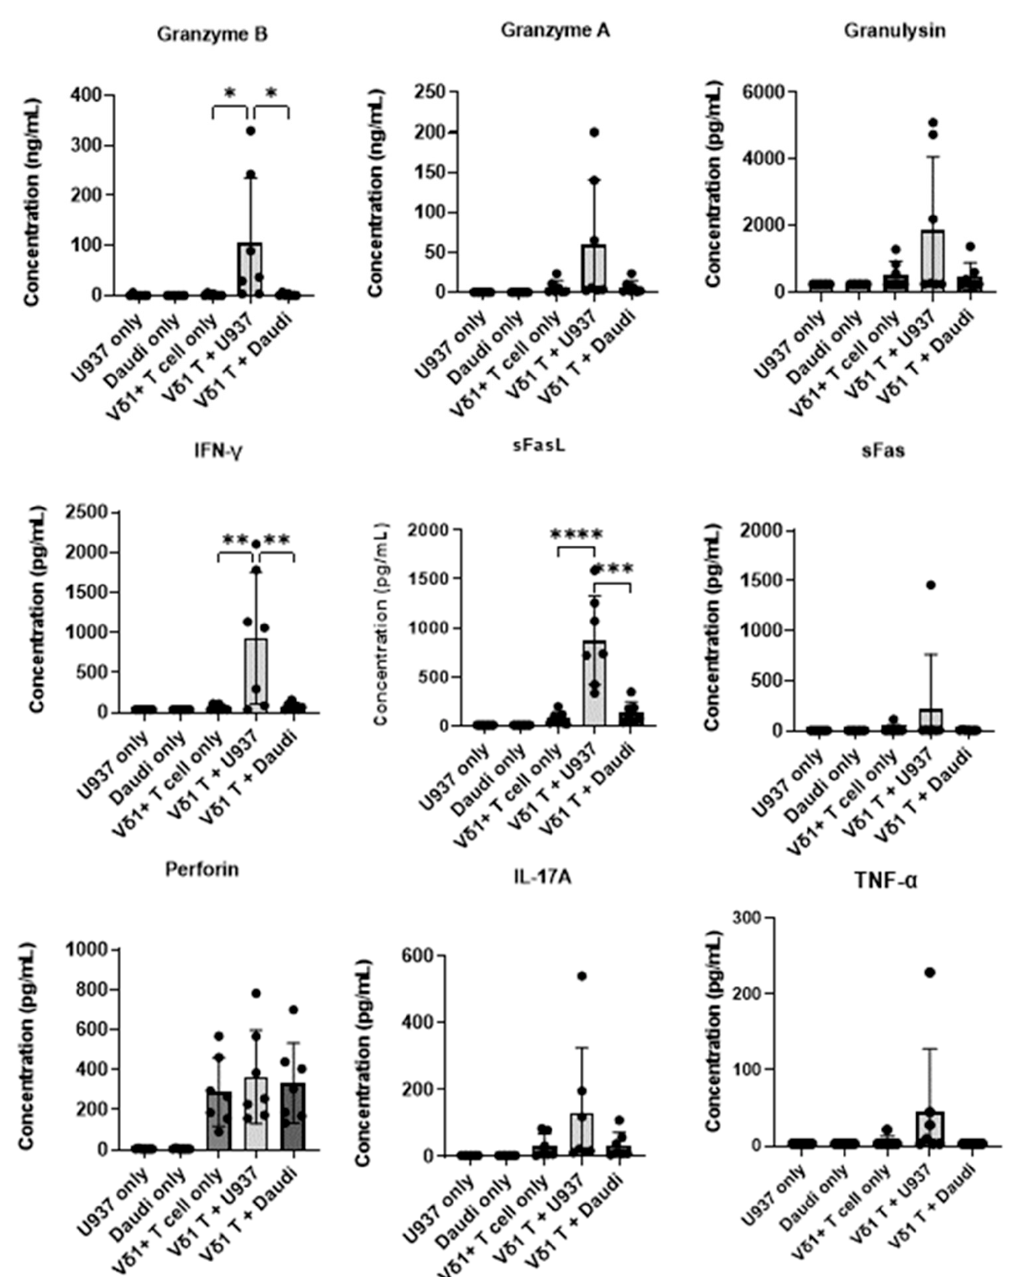
Figure 5. V δ 1+ T-cell secretome when co-cultured with tumor target cells. V δ 1+ T cells were co- cultured with or without target cell lines at an E:T ratio of 2:1 for 24 h. The supernatants were harvested, and cytokine profiles analyzed using a LEGENDplex human CD8/NK panel according to the manufacturer’s protocol. Experiments were analyzed with one-way ANOVA ( n = 7). Data shown are the mean ± SD of concentration of molecules or cytokines secreted by V δ 1+ T cells from 7 cord blood donors cultured alone or with indicated tumor cells, and representative of 2 independent experiments. (* p < 0.05, ** p < 0.005, *** p < 0.0005, **** p < 0.00005). E:T, effector:target; SD, standard deviation.